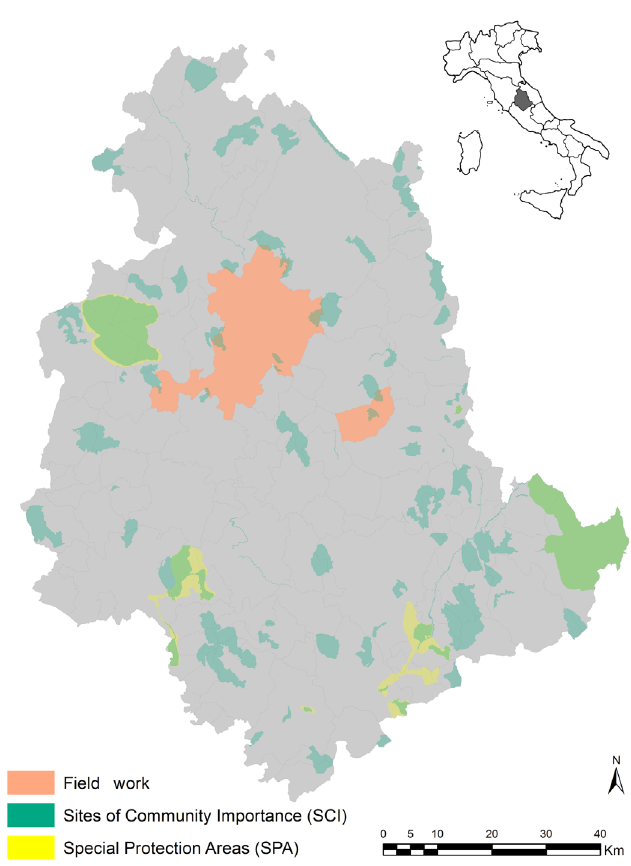
Fig. 1: Field work. Perugia and Spello, the municipalities where the themed events were organized. (Source: Umbria Geo Database, Umbria Region)